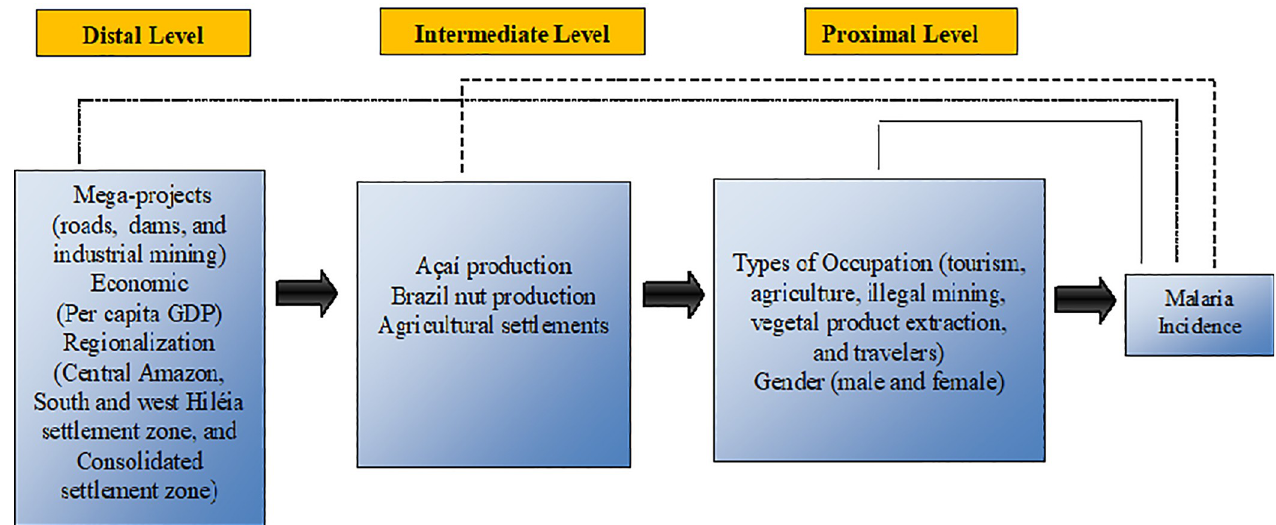
Fig 2. Theoretical and conceptual ecological model for the relationship between socioenvironmental determinants and malaria in the Brazilian Amazon.